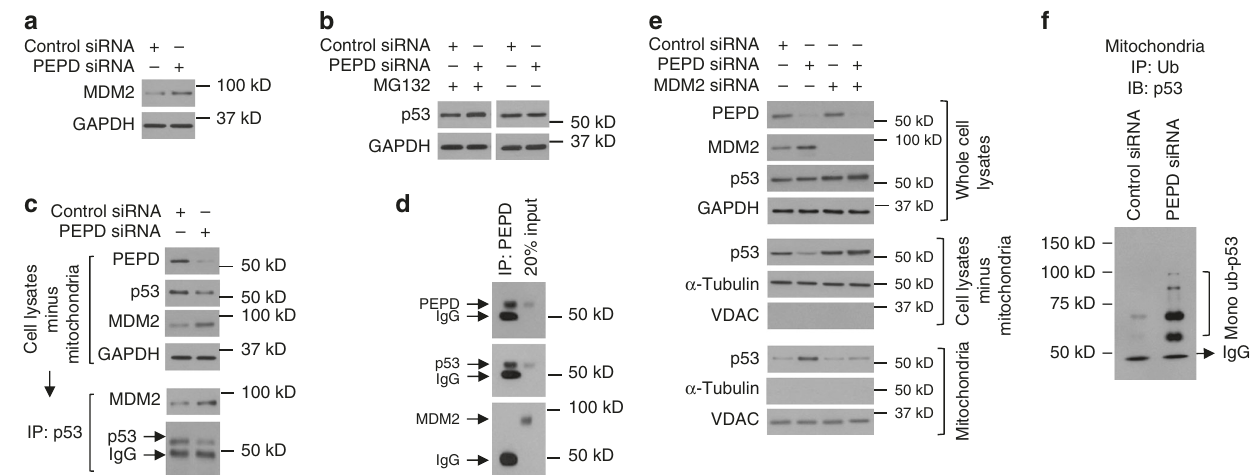
Fig. 7 PEPD blocks MDM2-mediated p53 move to mitochondria. a IB analysis of MDM2 in cells treated with siRNA for 72 h. b IB analysis of p53 in cells treated with siRNA and 24 h later treated with or without MG132 (25 μ M) for 48 h. c IB and IP-IB analyses of p53 association with MDM2 after cell treatment with siRNA for 48 h. d IP-IB analysis of MDM2 binding to the p53-PEPD complex. e IB analysis of mitochondria translocation of p53 in cells treated fi rst with control siRNA or MDM2 siRNA and 24 h later treated with control siRNA or PEPD siRNA for 48 h. MDM2 siRNA #1 was used (see Methods). f IB analysis of mitochondrial monoubiquitinated p53 in cells treated with siRNA for 48 h, with UbAl (100 μ M) added in the fi nal 4 h. GAPDH, α - tubulin and VDAC were measured to ensure the purity of subcellular fractions or as loading controls. Cells were cultured in 6-well plates (5 – 10 × 10 4 cells/ well) for 24 h before experimental